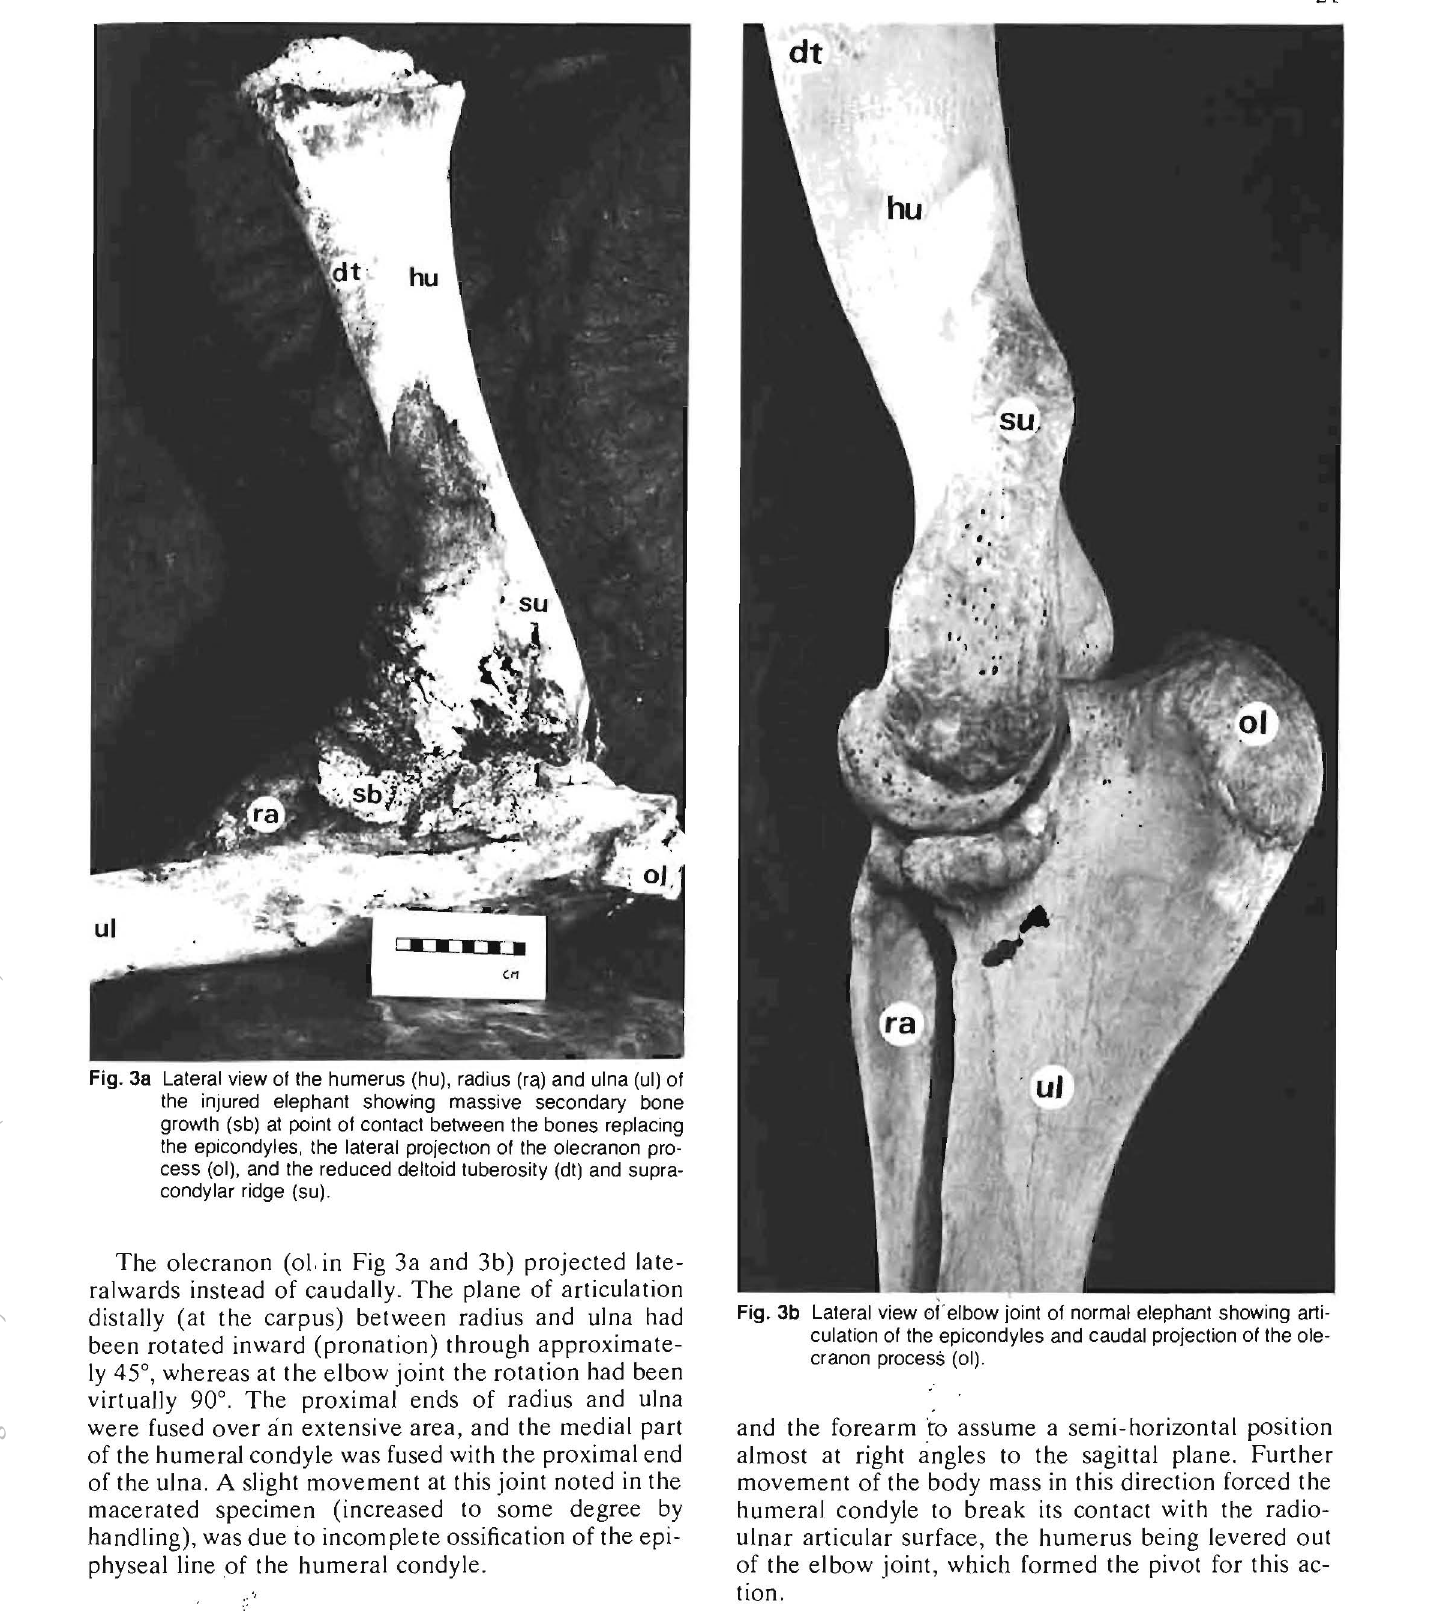
Fig. 38 Lateral view of the humerus (hu), radius (ra) and ulna (ul) of the injured elephant showing massive secondary bone growth (sb) at point of contact between the bones replacing the epicondyles, the lateral projechon of the olecranon pro· cess (01), and the reduced deltoid tuberosity (dt) and supra condylar ridge (su).